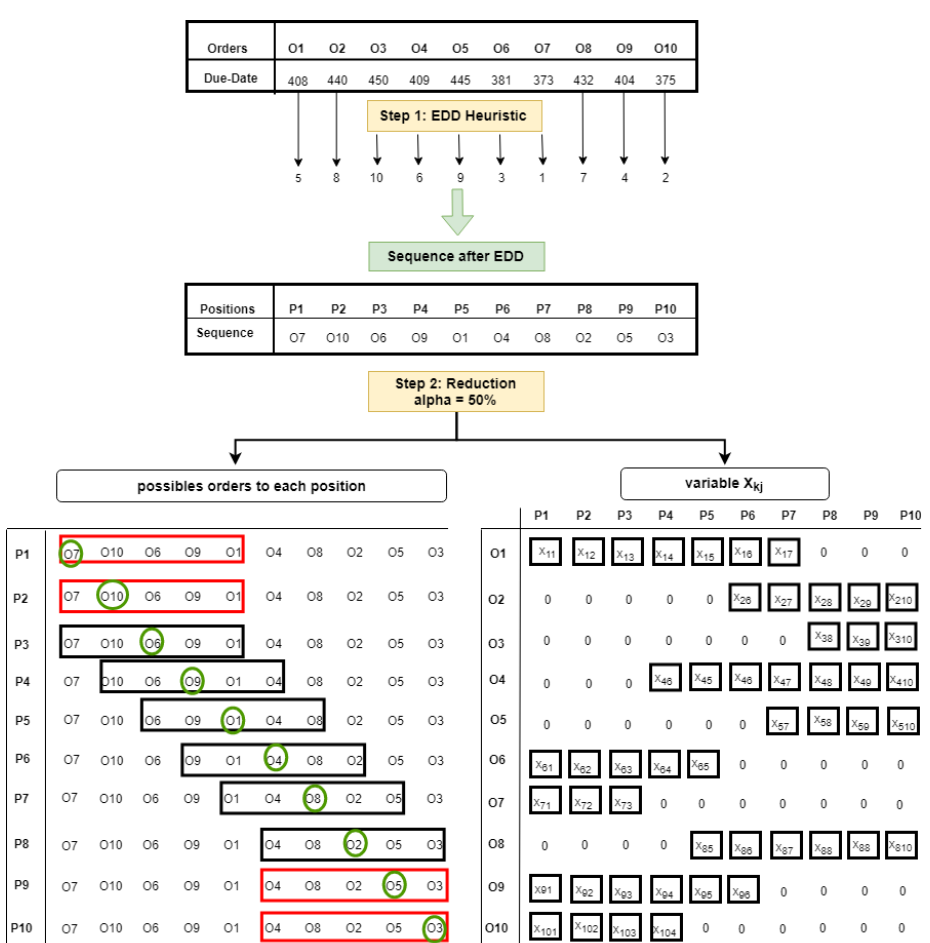
Fig. 2. Example of the proposed SR